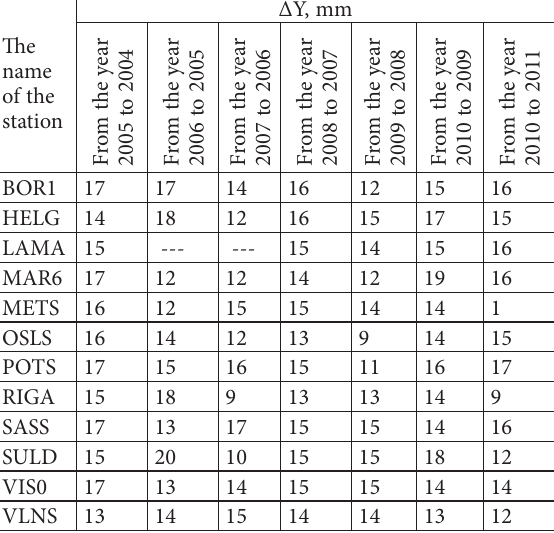
Table 2. The displacements of geocentric coordinate Y of the EUREF GPS